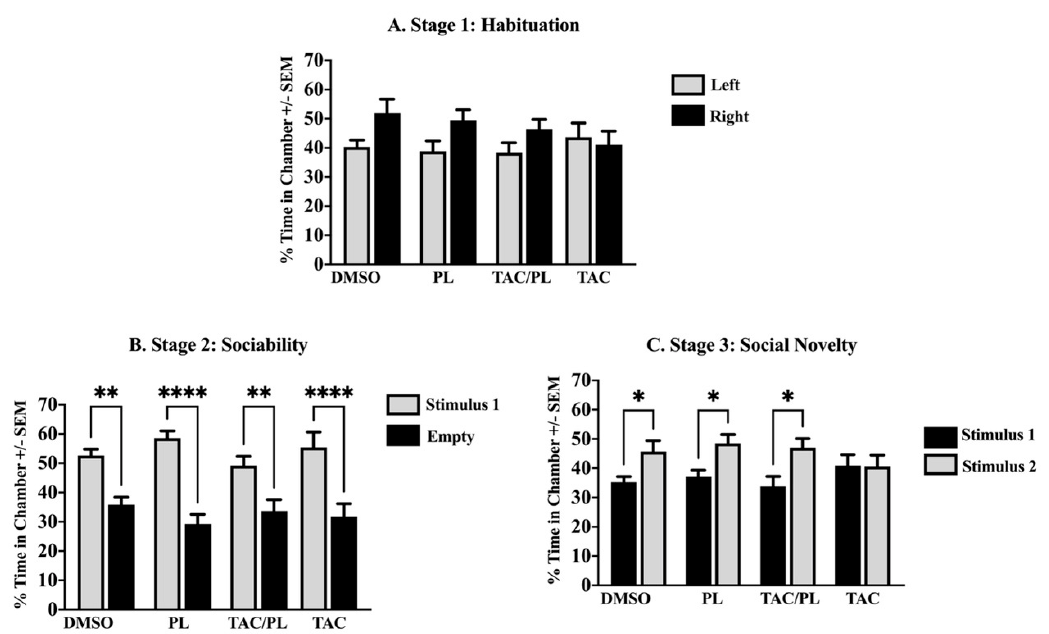
Figure 2. Sociability. ( A ) No significant difference in chamber exploration time in all groups. ( B ) Or- dinary social behavior in all treatment groups by spending significant time in a chamber with the novel mouse (stimulus 1). ( C ) Animals treated with DMSO, PL, and TAC/PL distinguished the previously present mouse (stimulus 1) from the newly presented mouse (stimulus 2). Only the TAC-treated animals failed to distinguish between the previously present mice (stimulus 1) and the newly introduced mice (stimulus 2). One-way ANOVA, average ± SEM; Holm-Sidak multiple comparisons * p < 0.05, ** p < 0.01, **** p < 0.0001. ( n =